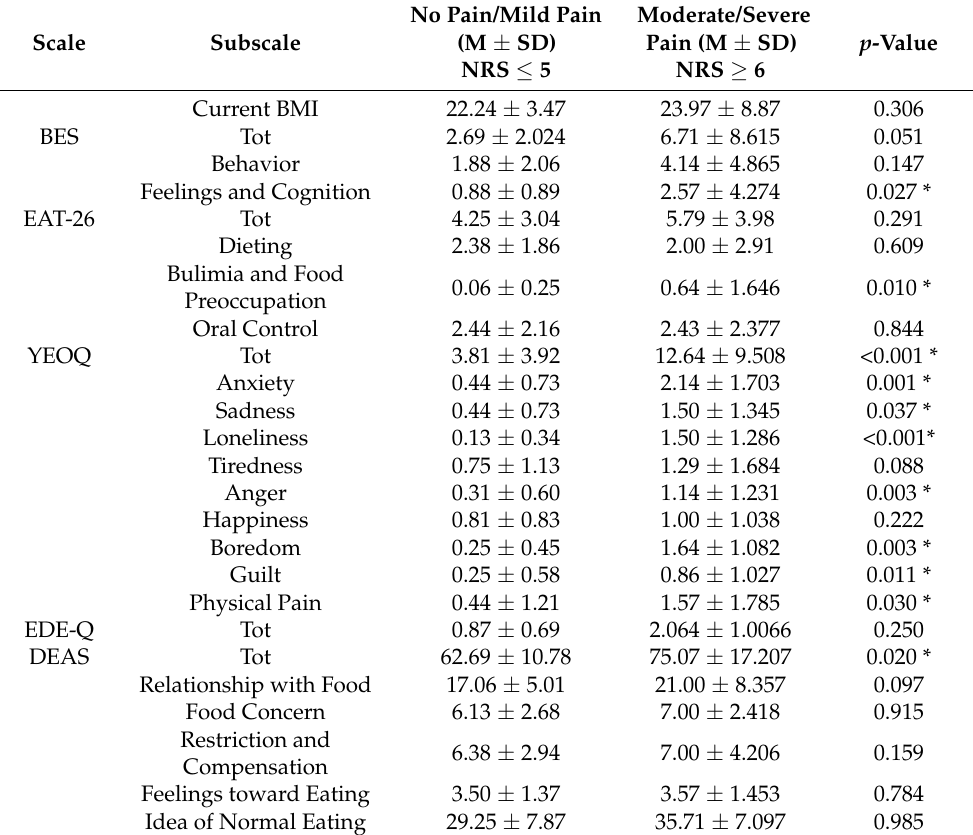
Table 5. Mean scores differences between groups on NRS cutoff.